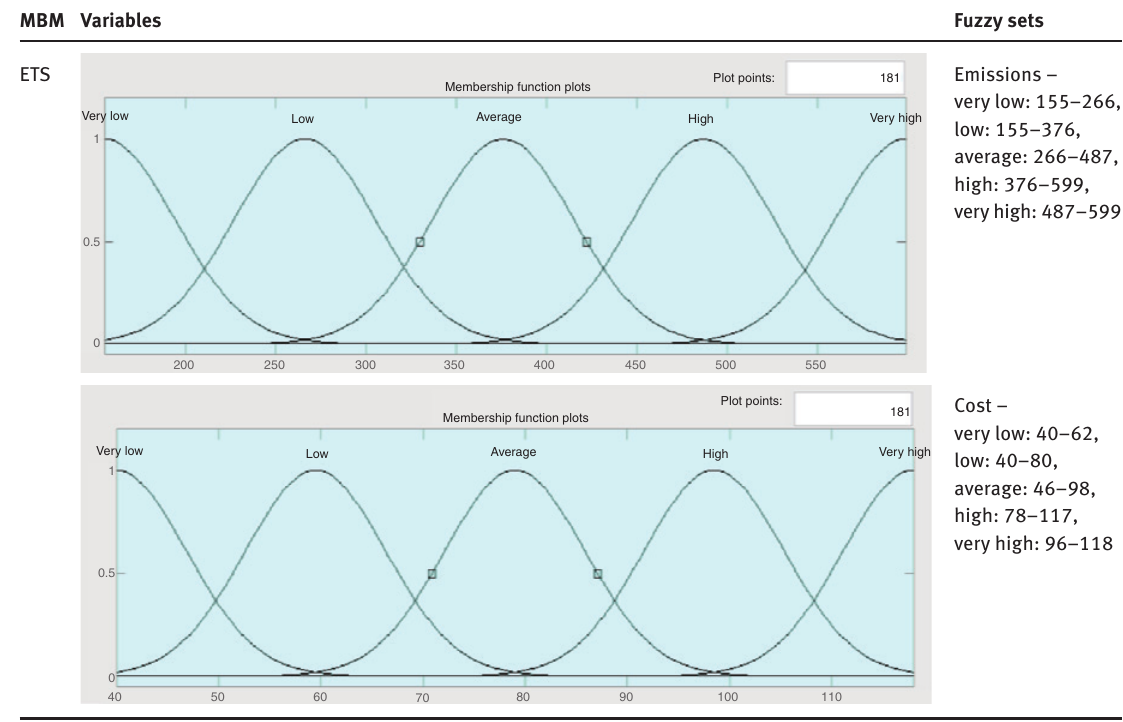
Table 2: Fuzzification of the Output Variables. MBM Variables Fuzzy